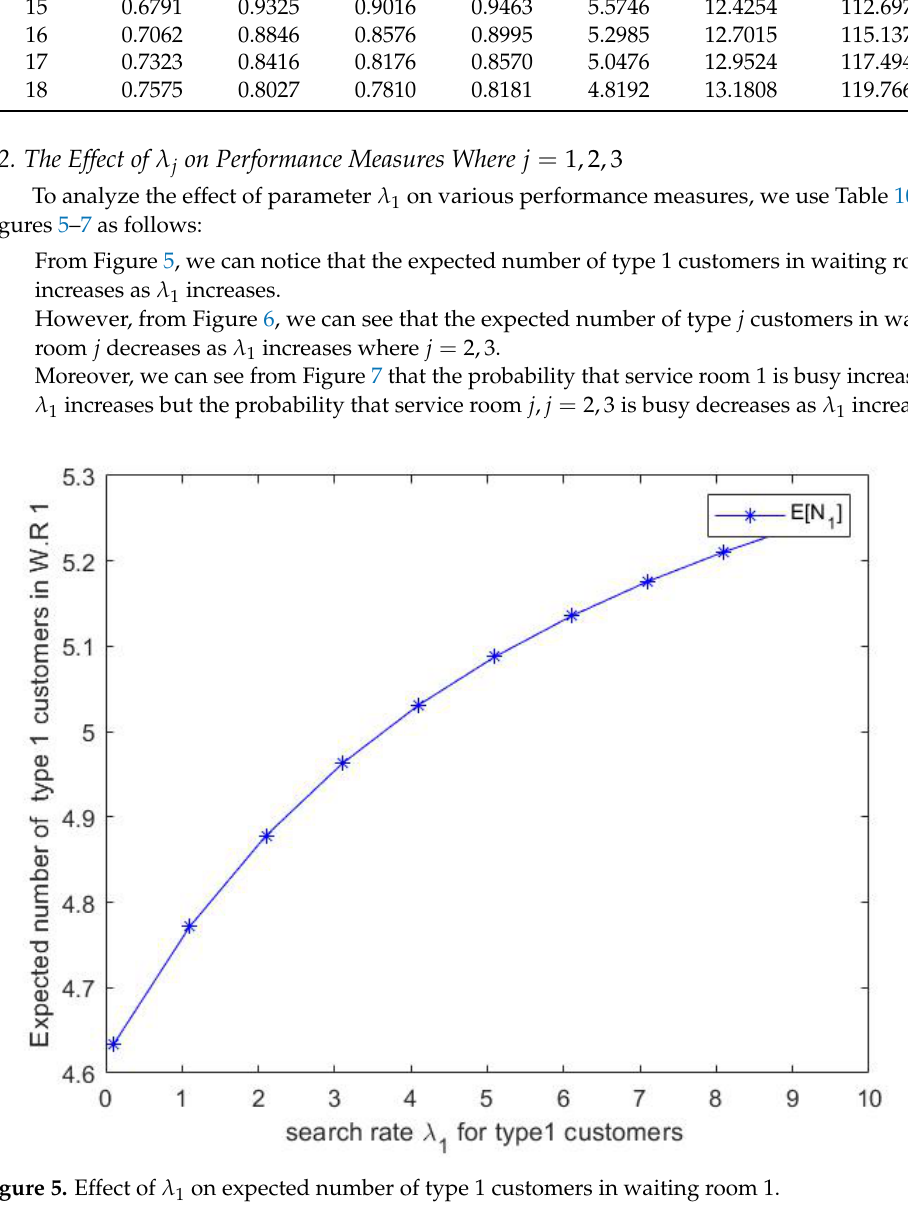
Figure 5. Effect of λ 1 on expected number of type 1 customers in waiting room